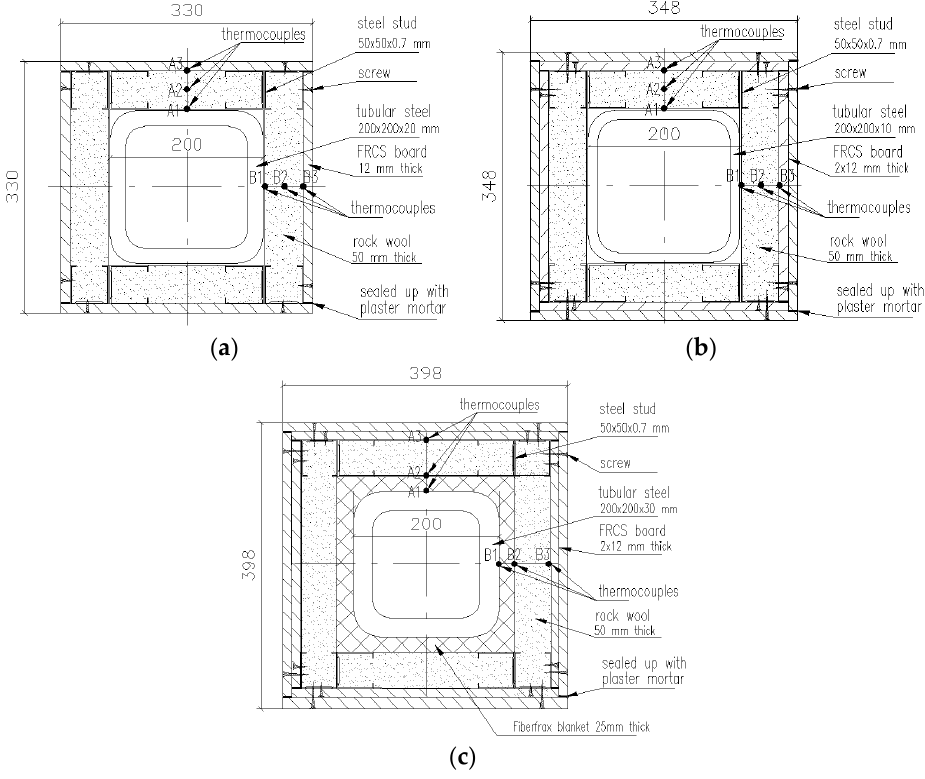
Figure 3. Cross-section view of the three columns with protection: ( a ) HSS-C1; ( b ) HSS-C2; ( c ) HSS-C3.